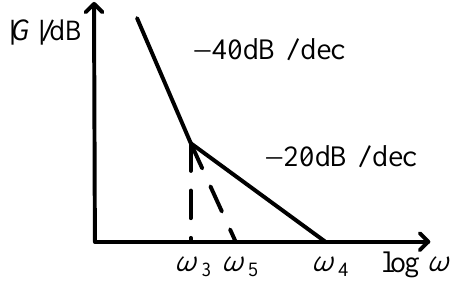
Figure 5. Frequency characteristics of phase control loop of driving